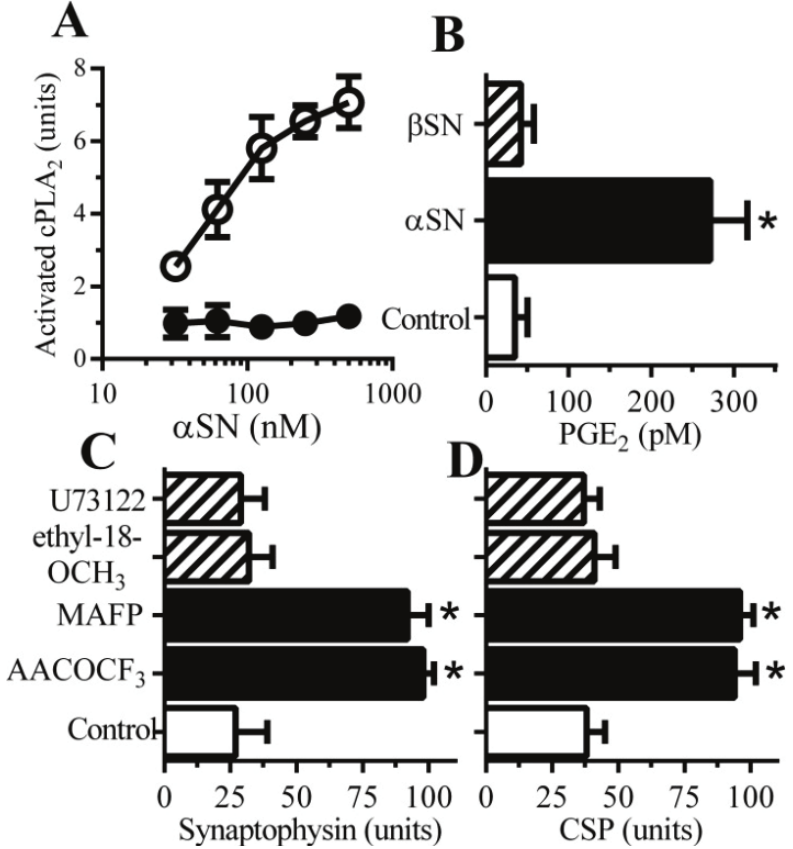
Figure 2. PLA 2 inhibitors protect neurons against (cid:2)SN-induced synapse damage—( A ) The amounts of activated cPLA 2 in synaptosomes incubated with (cid:2)SN ((cid:4)) or (cid:3)SN ((cid:5)) as shown. Values are means ± SD from triplicate experiments performed three times, n = 9; ( B ) The concentrations of PGE 2 produced by synaptosomes incubated with control medium ((cid:6)), 500 nM (cid:2)SN ((cid:7)) or 500 nM (cid:3)SN (striped bar). Values are means ± SD from triplicate experiments performed three times, n = 9. * = significantly higher than in control synaptosomes. The amounts of synaptophysin ( C ) and CSP ( D ) in neurons pre-treated with control medium ((cid:6)), phospholipase A 2 inhibitors (1 μM AACOCF 3 or 1 μM MAFP) ((cid:7)) or phospholipase C inhibitors (10 μM U73122 or 10 μM ethyl-18-OCH 3 ) (striped bars) and incubated with 1 (cid:8)M (cid:2)SN. Values are means ± SD from triplicate experiments performed four times, n = 12. * = significantly higher than in control neurons incubated with